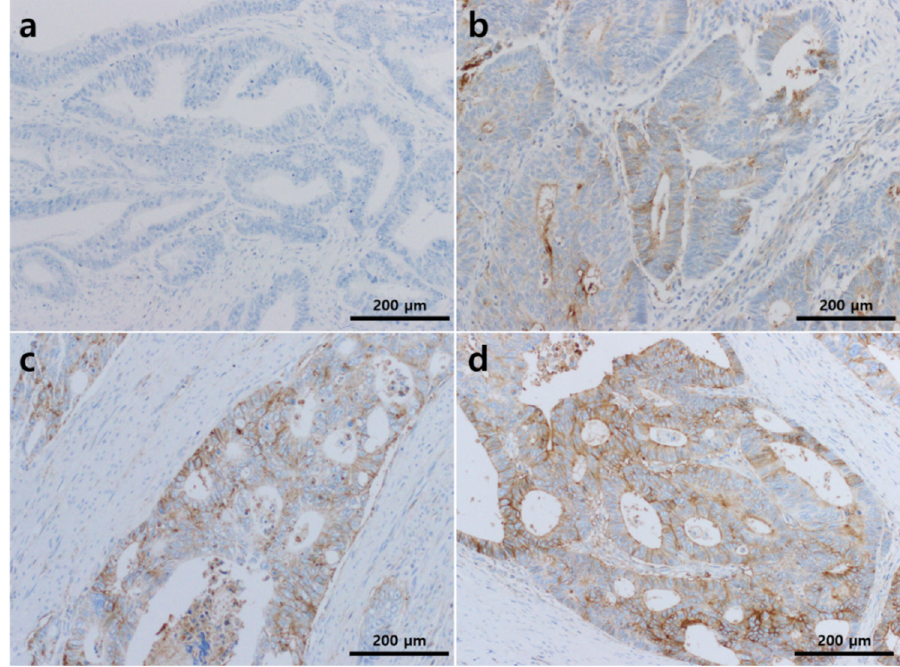
Figure 1. CD47 expression in colorectal adenocarcinoma tissues. The intensity of membranous staining was graded as ( a ) negative, 0; ( b ) weak, 1+; ( c ) moderate, 2+; or ( d ) strong, 3+ (A − D, × 200).